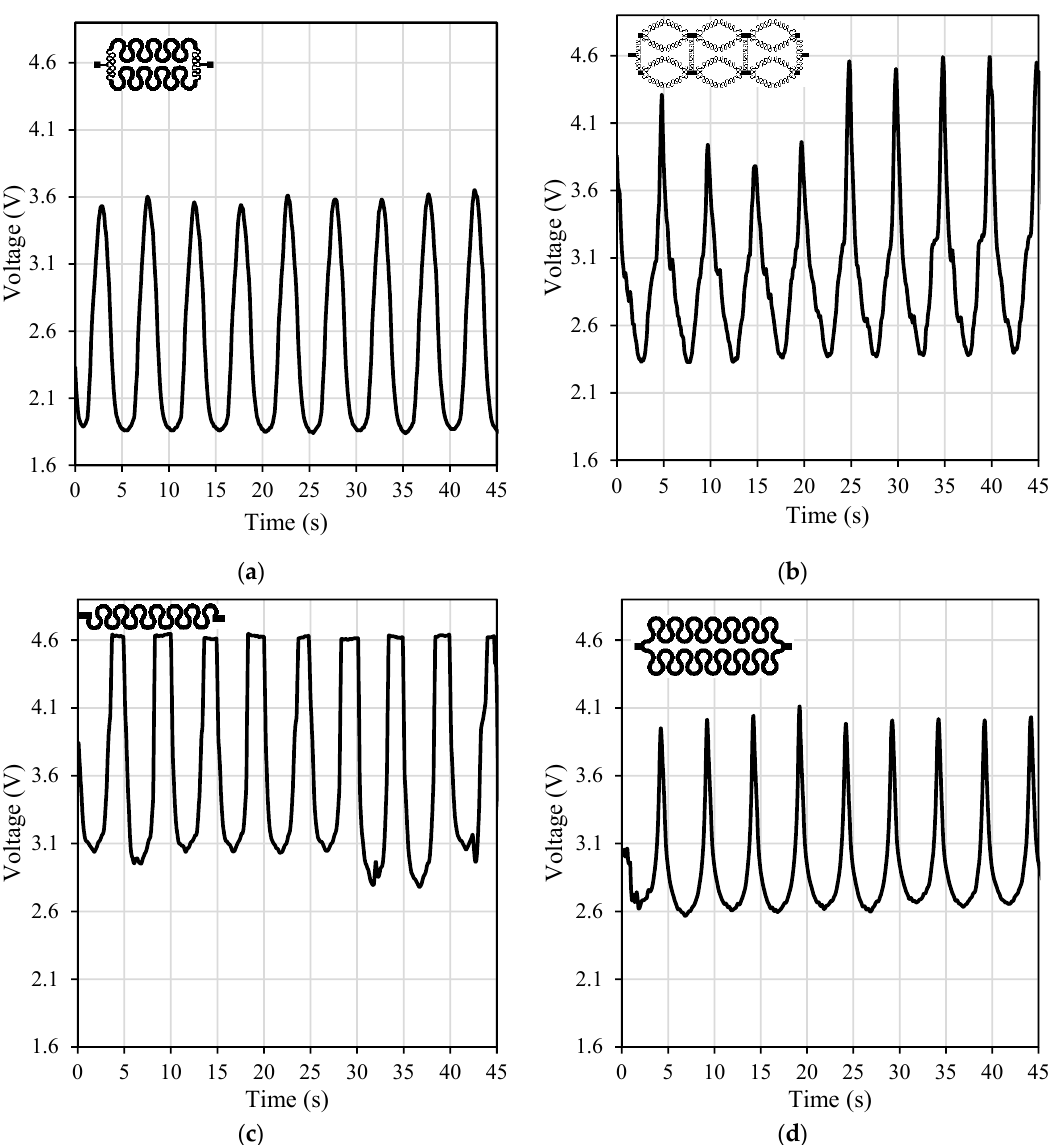
Figure 11. The output voltage over time from the four selected patterns under 3% axial strain at 800 steps/s speed: ( a ) design #1, ( b ) design #3, ( c ) design #5, and ( d ) design #6.